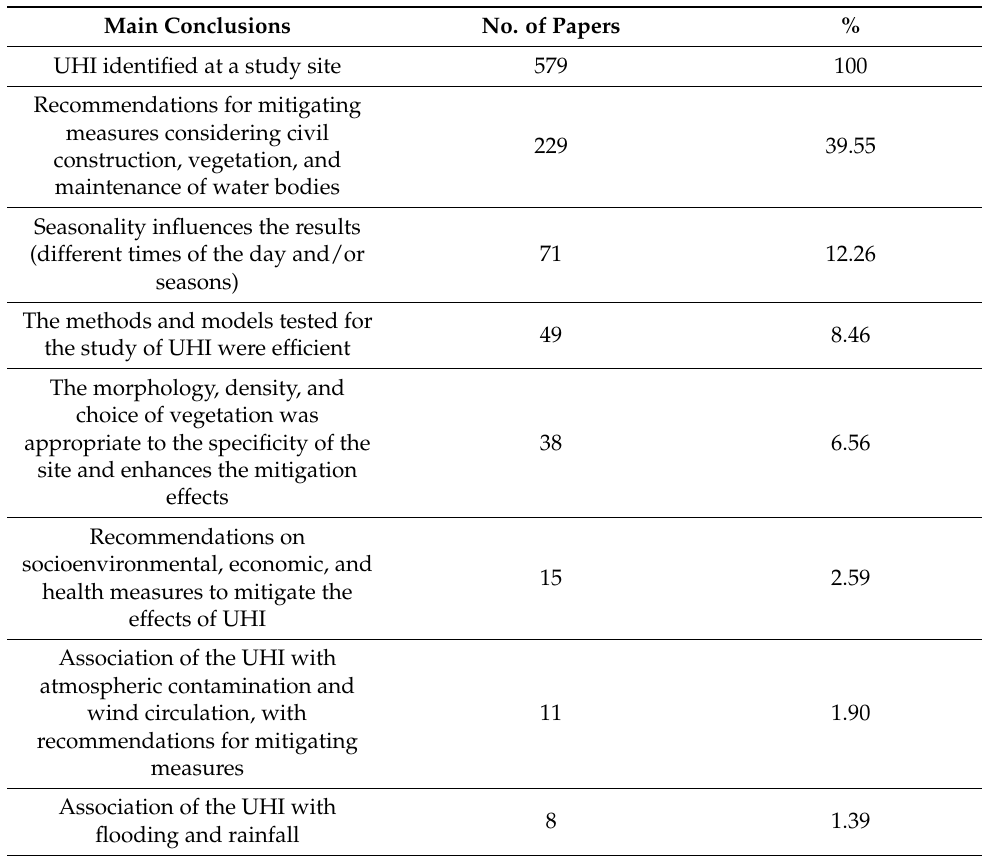
Table 12. Main findings of the